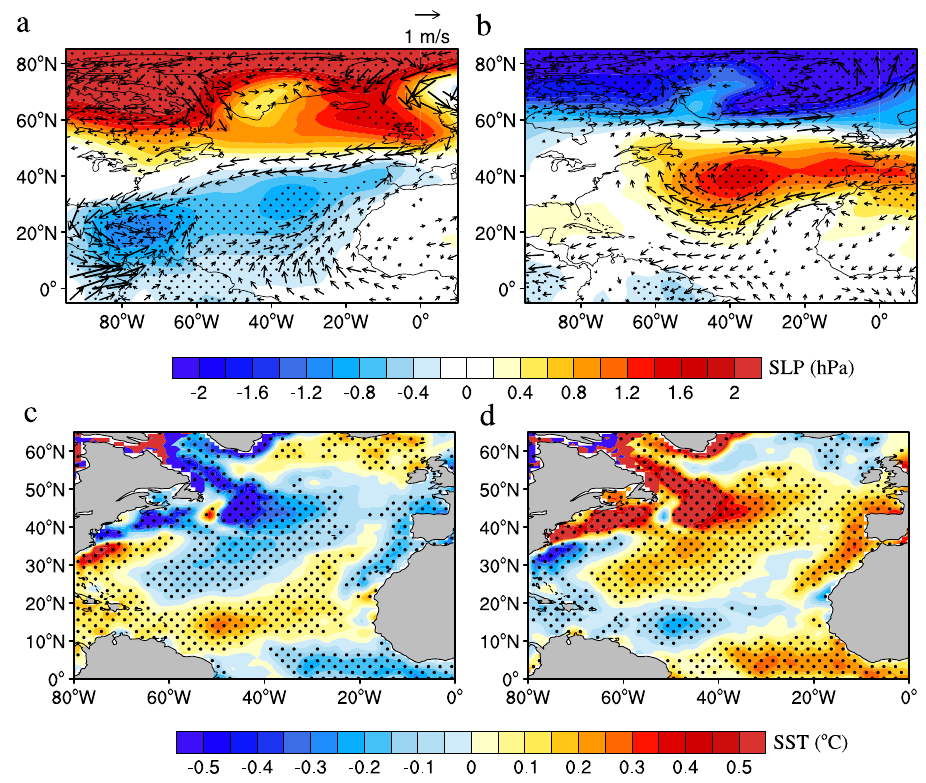
Fig. 2 | Composite differences of sea level pressure (SLP), 850-hPa winds, and sea surfacetemperature(SST)anomalies.a , b Composite differences of 850-hPa winds (vectors, m s − 1 ) and SLP (shading, hPa)anomaliesduring the previous boreal winter – spring seasons (D − 1JFMAM0) between 1947 – 1985 (P2) and 1913 – 1939 (P1) ( a ) and between 1993 – 2010 (P3) and 1947 – 1985 (P2) ( b ). c , d As in a , b , but for